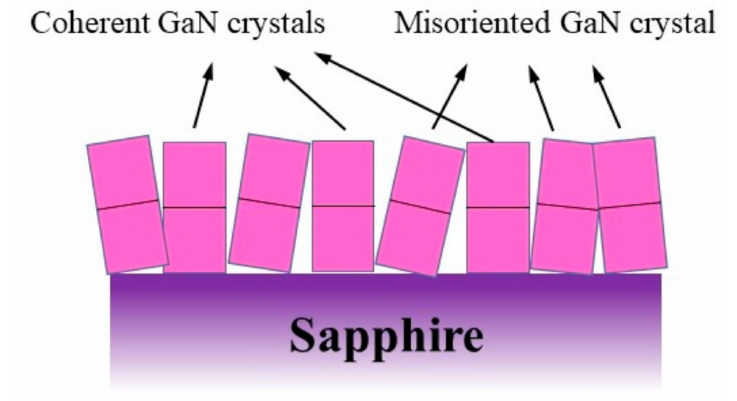
Figure 7. The GaN NL crystal structure